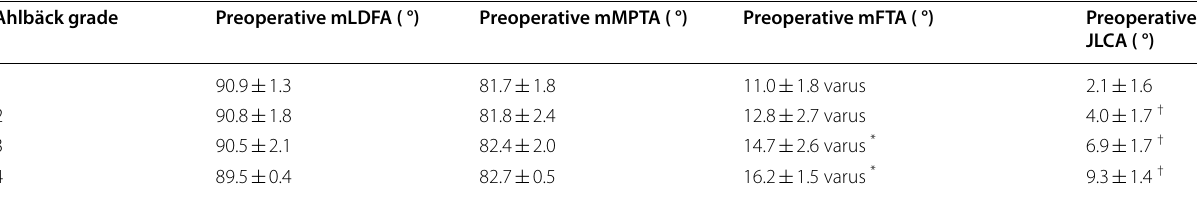
Significant differences in mTFA between grade 1 and grade 3, 4 knees by one-way ANOVA with Turkey’s post hoc test (*P < 0.01) Significant differences in JLCA between grade 1 and grade 2, 3, 4 knees by one-way ANOVA with Turkey’s post hoc test ( † P < 0.01) mLDFA: mechanical lateral distal femoral angle mMPTA: mechanical medial proximal angle